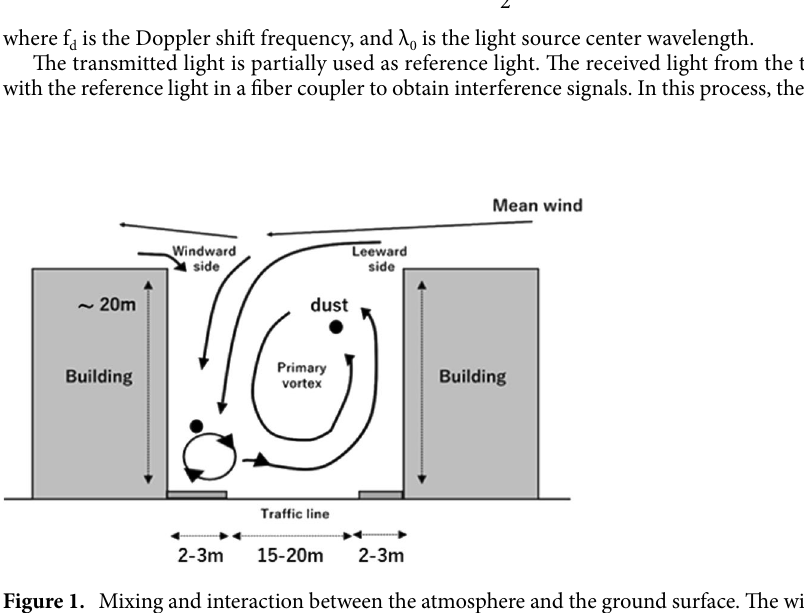
Figure 1. Mixing and interaction between the atmosphere and the ground surface. The wind fields generated by buildings and asphalts show how dust flows on a small spatio-temporal scale 4